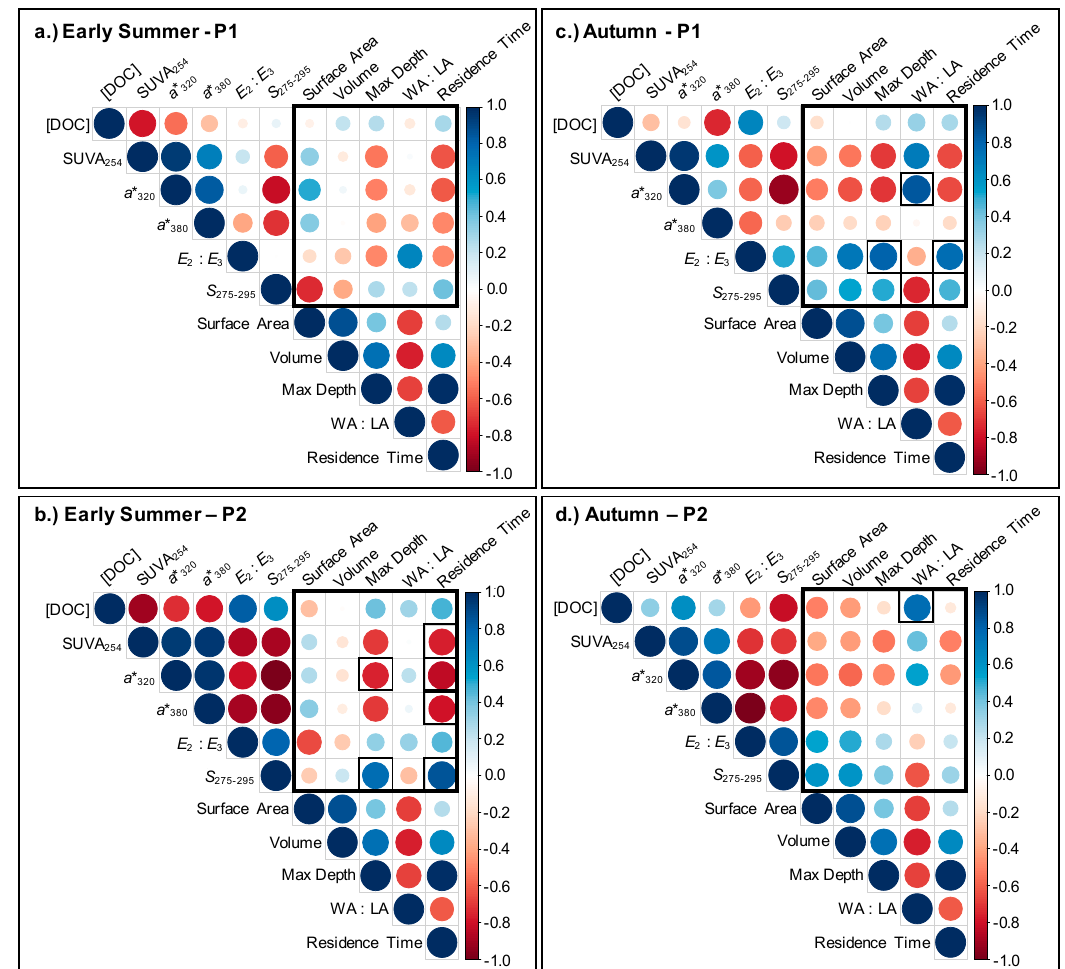
Figure 4. Correlations between the percent change of [DOC], SUVA 254 , a * 320 , a * 380 , E 2 : E 3 , S 275–295 and select lake characteristics (outlined in the larger boxes) during the Early Summer for ( a ) P1 and ( b ) P2 and Autumn ( c ) P1 and ( d ) P2 storm samplings. Bold borders on cells (within the larger boxes) indicate significant relationships ( p < 0.10) between DOC metrics and lake characteristics. Larger circles indicate stronger correlations, red circles indicate negative correlations and blue circles indicate positive correlations. WA:LA indicates the ratio of watershed area to lake area.